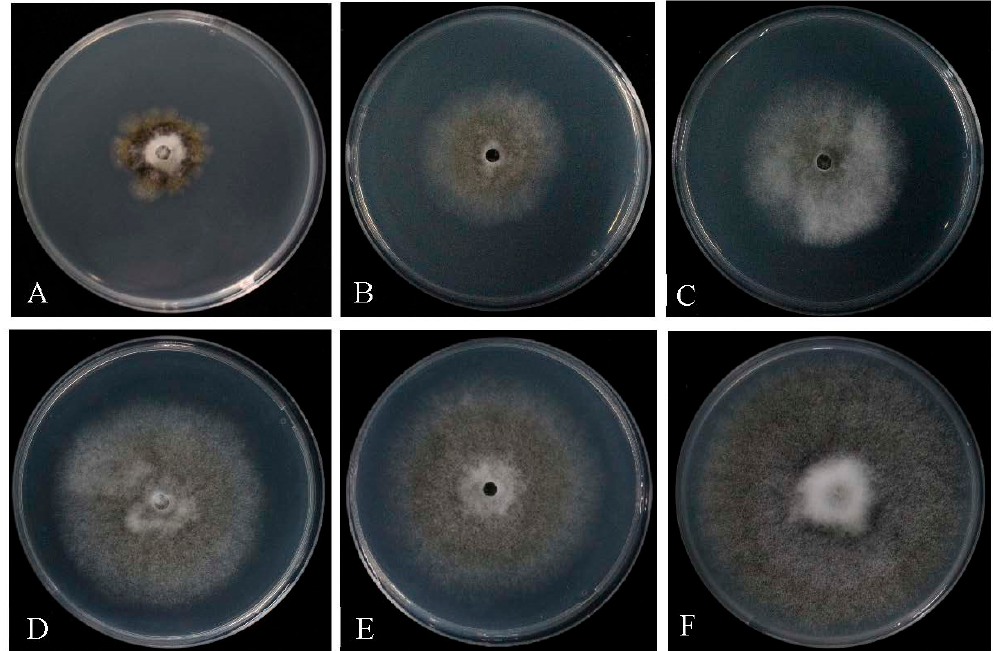
Figure 7. Antagonistic activity levels of Trichoderma T6 fermentation against Monilia yunnanensis after inoculation at 7 days: ( A – F ) the antagonistic activity levels of 20-, 40-, 80-, 160-, and 320-fold fermentation dilutions and the sterile water (control), respectively.